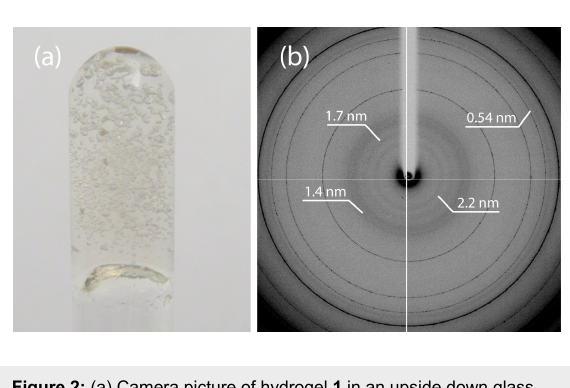
Figure 2: (a) Camera picture of hydrogel 1 in an upside down glass test tube and (b) low–medium-angle XRD pattern from a fragment of the hydrogel 1 collected at 100 K. In (b) the periodicities associated with diffraction rings due to the ordered assembly of 1 are indicated. Those not listed are due to